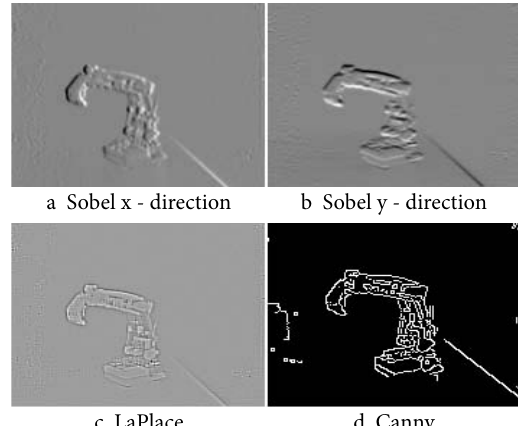
Fig. 4. Edge detection